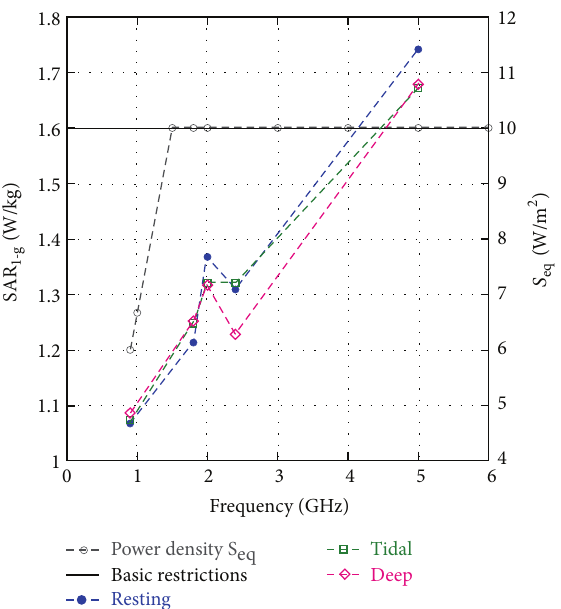
Figure 8: SAR 1 in the lungs for the RS, TB, and DB models -g obtained for FCC reference levels. The FCC power density reference level allowed for general population is also